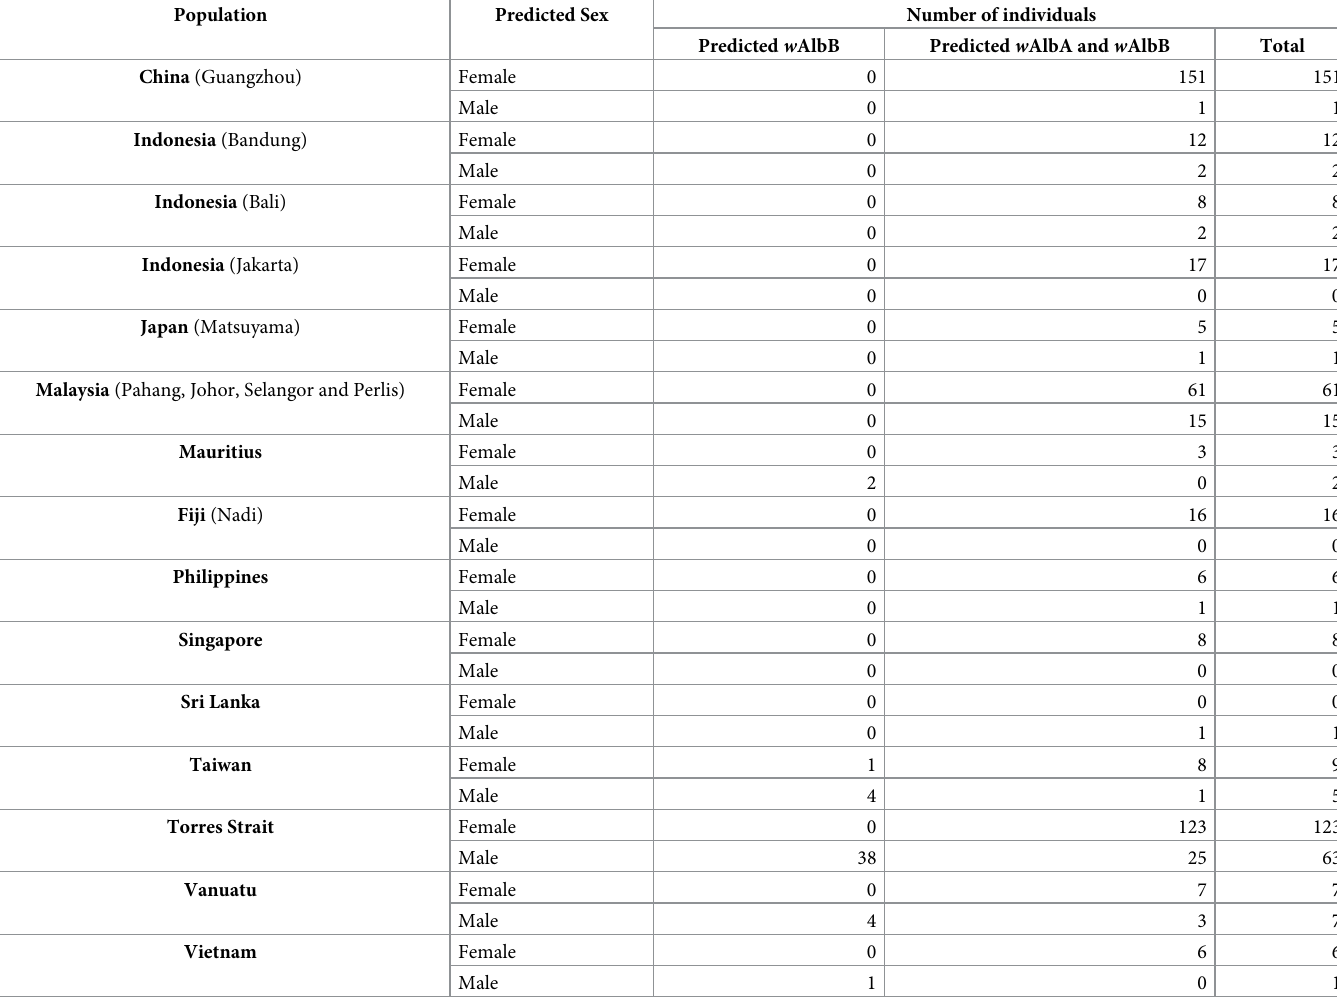
Table 5. Sex and strain distribution of Wolbachia infection status in Ae . albopictus using classification results. Only samples with > 60% classification probability in both sex and Wolbachia strain prediction are included.